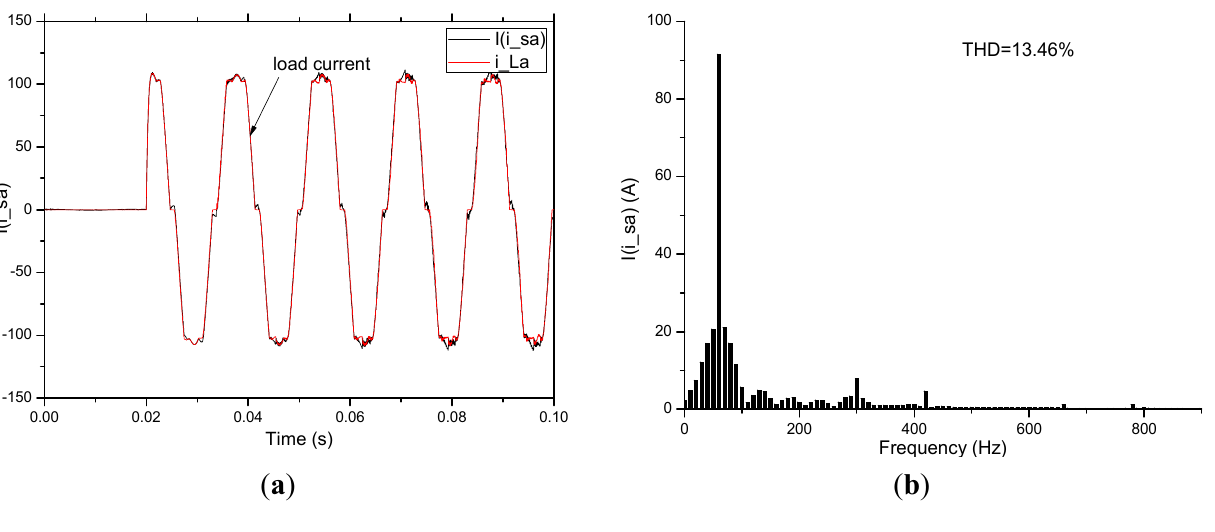
Figure 6. Phase current and spectrum of the non-linear load: ( a ) load current; and ( b ) spectrum of the load current. THD: total harmonic